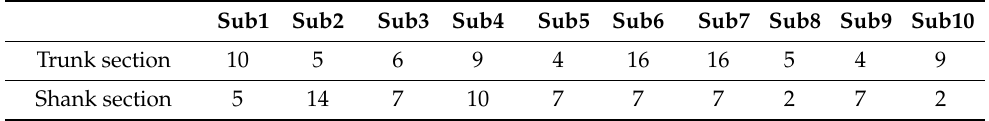
Table 11. Results of selecting 3DP-pHRI size